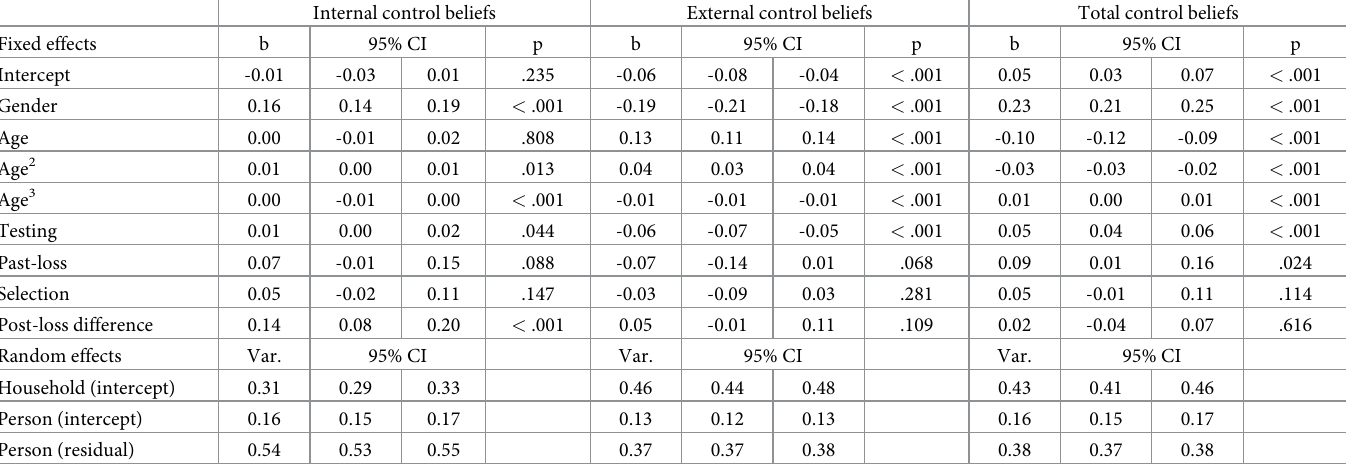
Table 4. Differences in perceived control between individuals who did ( N = 1,235) and did not ( N = 13,537) separate from a partner between 1991 and 1999 ( N = 14,772).